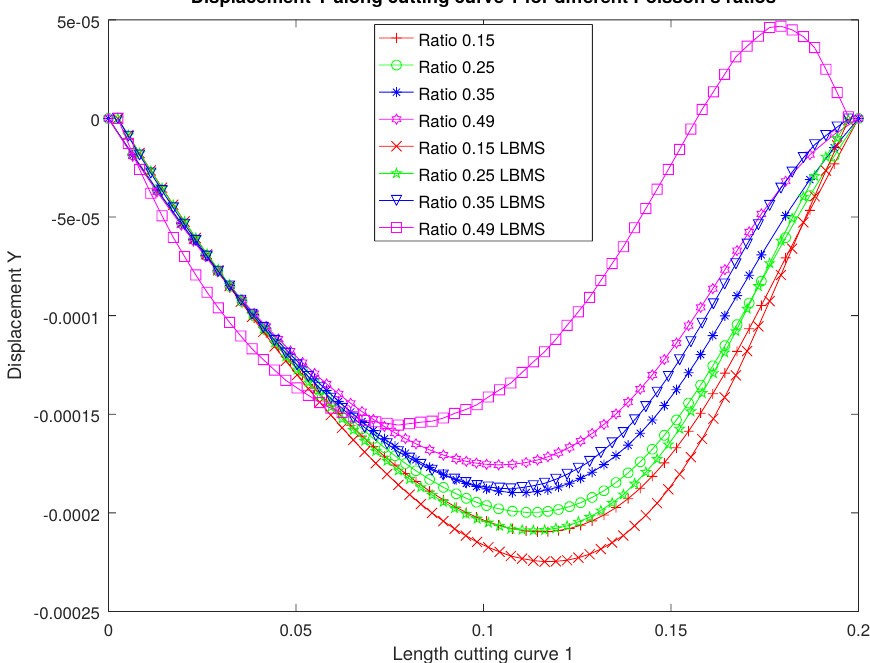
Figure A10. Second displacement component along cutting curve C 1 for positive Poisson’s